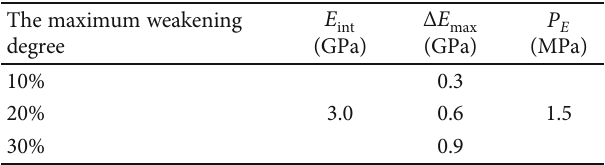
Table 5: Numerical simulation